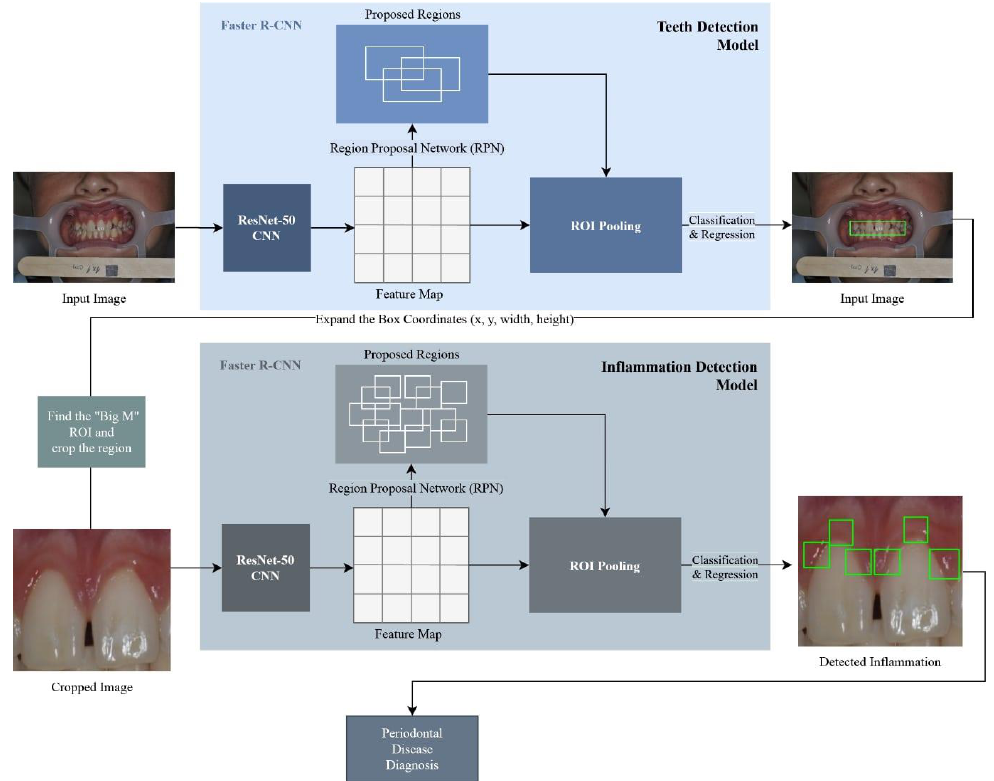
Figure 3 . Proposed methodology architecture . Figure 3. Proposed methodology